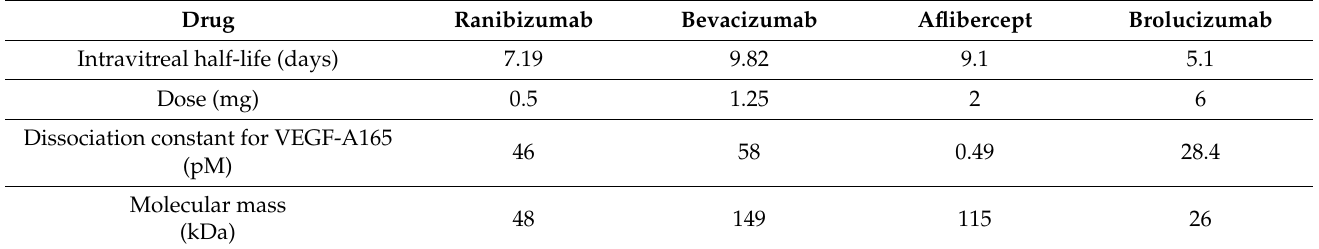
Table 1. Pharmacokinetic and affinity data for intravitreal